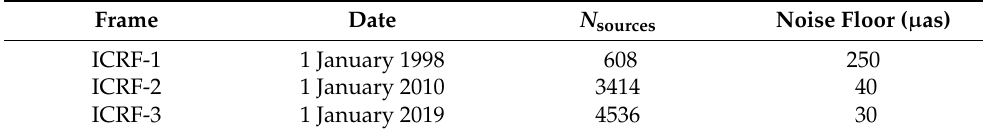
Table 1. Overview of the three generations of S/X-band ICRFs. The date gives the start of each frame as the IAU standard. N sources gives the number of extragalactic radio sources in each S/X-band frame. The noise floor is the minimum realistic error based on internal repeatability studies. Note the trend of increasing number of sources and decreasing noise